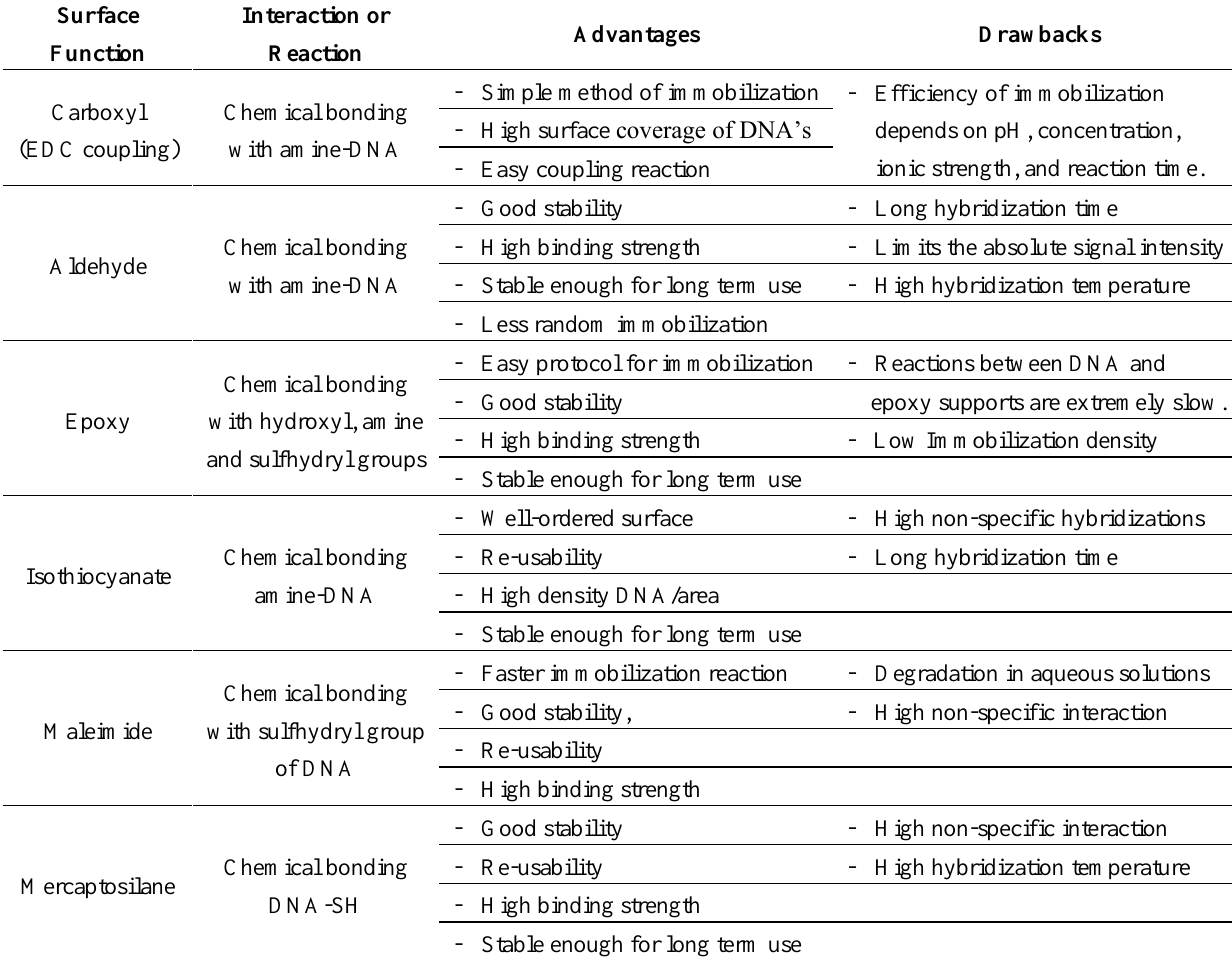
Table 3. The advantages and drawbacks of functionalized DNA chip